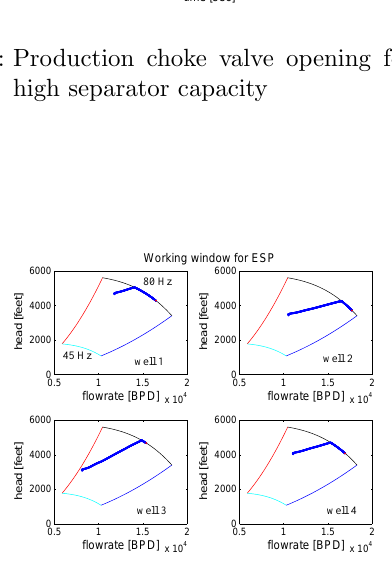
Figure 9: Operating window of ESPs for a very high separator capacity